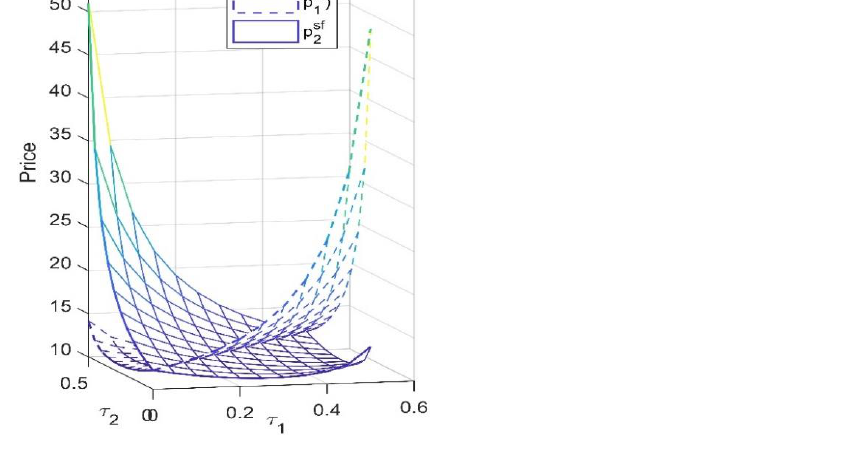
Figure 5. Changes in the price with the free-riding coefficient in the fourth case.